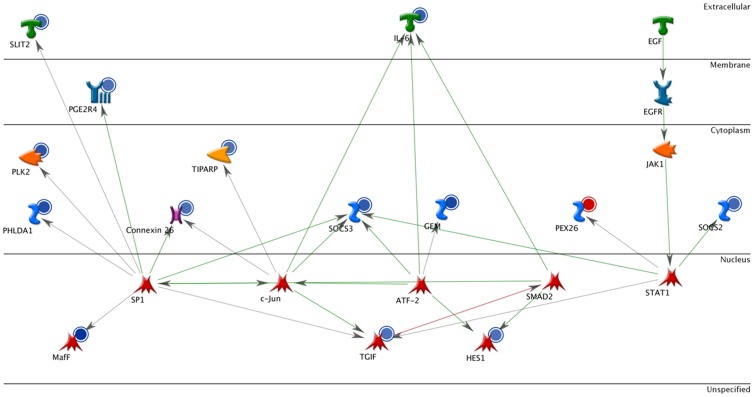
Transcripts showing both DNA methylation and expression changes between naïve normal and asthma-at-risk DCs form a small interaction network focused on regulation of a pleiotropic cytokine IL-6.Interacting factors are depicted in various shapes depending on their biological nature, connecting arrows indicate known links. Blue circles indicate transcripts down-regulated in asthma-at-risk DCs, red – up-regulated.